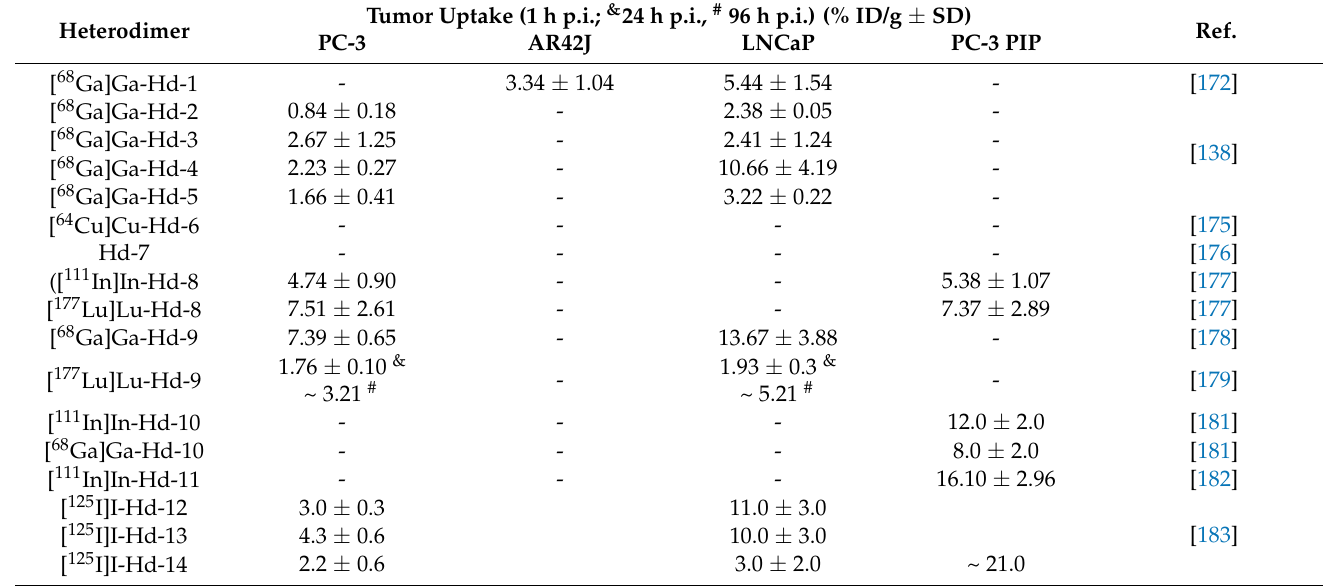
Table 3. Heterodimers targeting PSMA/GRPr, tumor uptake (1 h p.i.) expressed as (% ID/g) in PC-3, AR42J, LNCaP or PC-3 PIP xenografts (Mean value ±